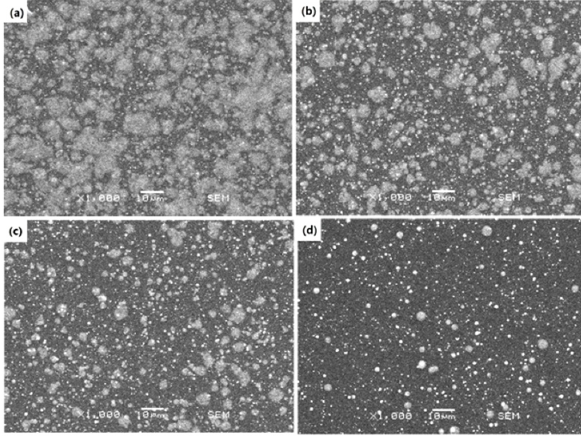
Figure 4. SEM images of the BTO single layer fabricated with different jet heights: ( a ) 4 mm, ( b ) 5 mm, ( c ) 6 mm and ( d ) 10 mm.